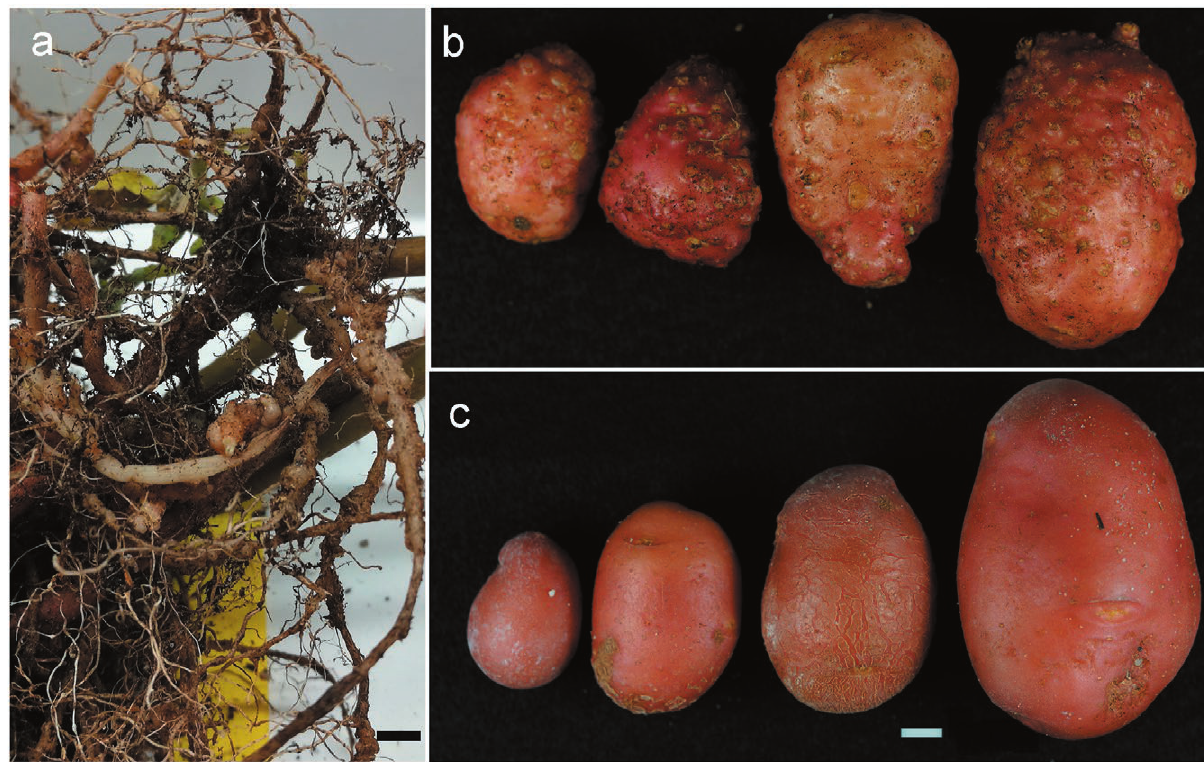
Figure 1. Symptoms of infection by the root-knot nematode Meloidogyne inornata on Solanum tuberosum ‘Désirée’. a) Roots with galls. b) Tubers with surface galls. c) Uninfected potato tubers. Scale bars = 1